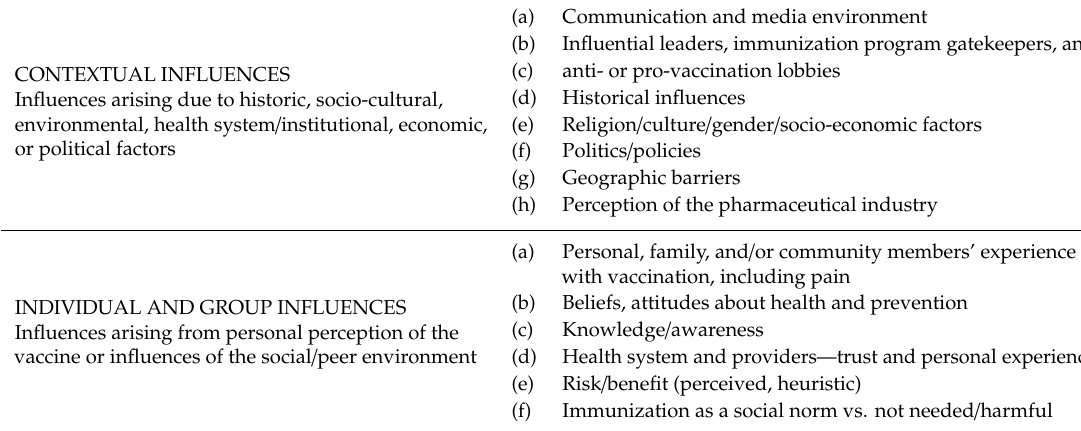
Table 4. The WHO SAGE Working Group Determinants of Vaccine Hesitancy Matrix [29].